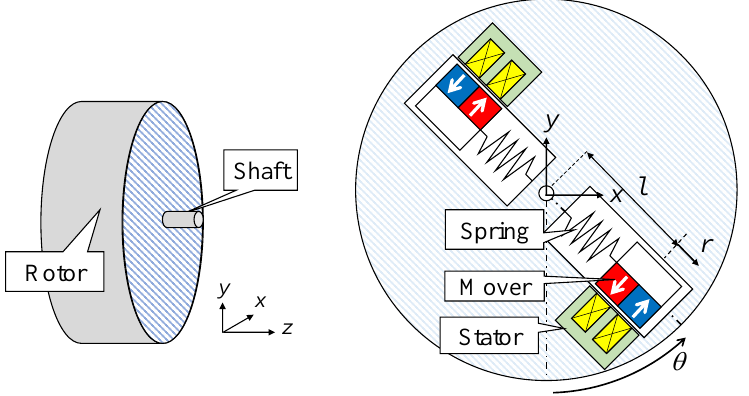
Figure 1. Configuration of the proposed energy